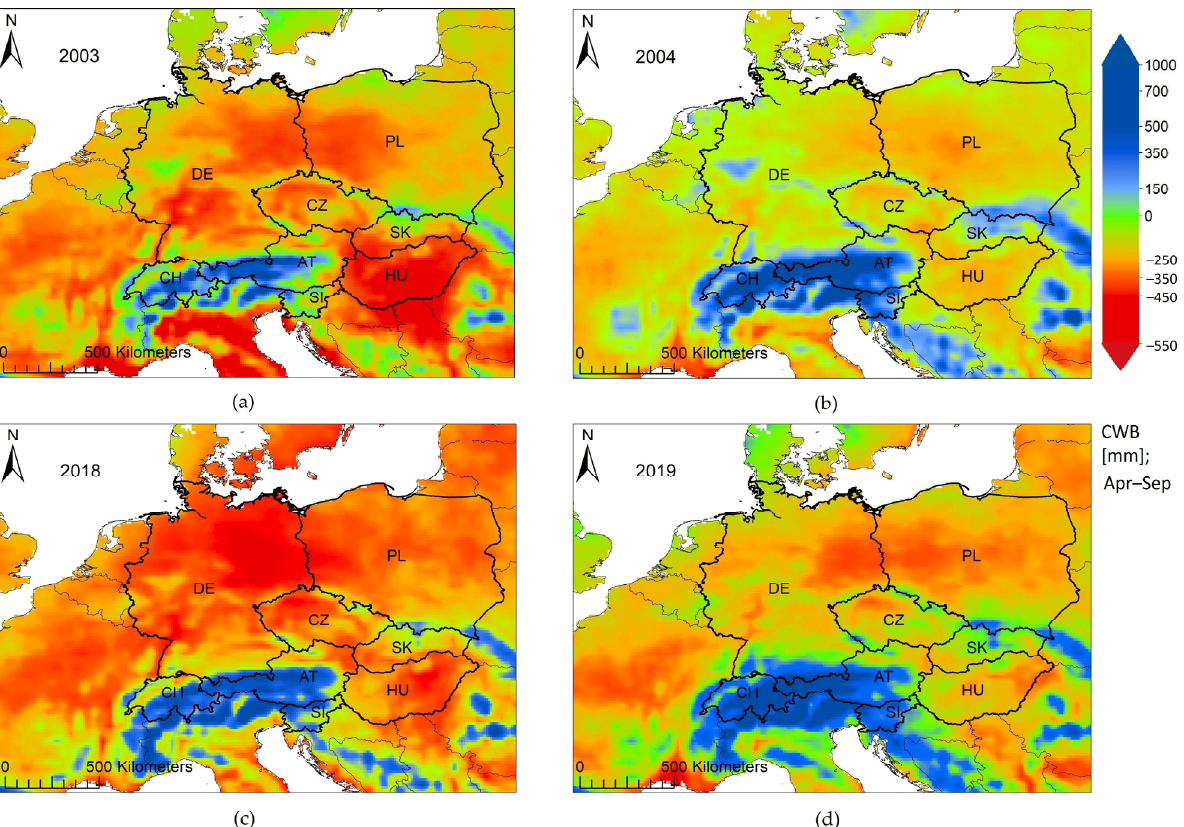
Figure 2. Sum of the climatic water balance (CWB, mm) over the vegetation period from April to September for the years 2003 ( a ), 2004 ( b ), 2018 ( c ), and 2019 ( d ) over Central Europe. CWB was calculated as the difference between monthly precipitation [28] and monthly potential evapotranspiration (PET, mm). PET was calculated separately [37,38], utilizing the latitude and monthly mean temperature [28] in the SPEI package [39] of the R software [40]. Each assessed grid point is 0.1 × 0.1 degree, roughly 9 × 9 km. AT: Austria; CH: Switzerland; CZ: Czechia; DE: Germany; HU: Hungary; SI: Slovenia; SK: Slovakia; PL: Poland. Shapefiles of countries downloaded from Eurostat [41]. The downloaded ERA-5 Land climate data for temperature and precipitation [28] existed in NCDF format, was read into R software using the package “ncdf4” [42]. Raster package [43] was used to convert this NCDF data into raster format. See Text S1 for detailed methods description. © Thünen Institute, 2022.